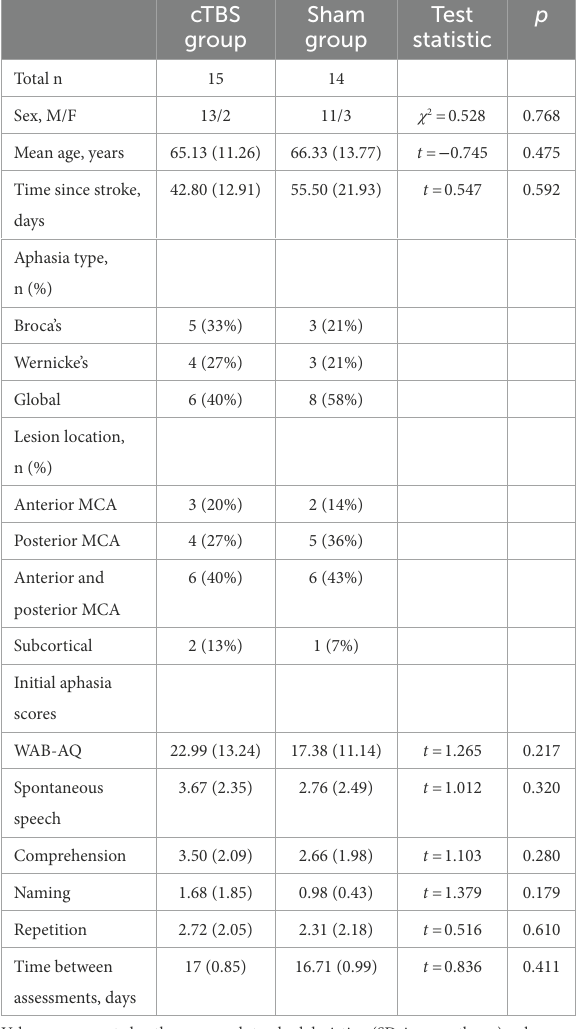
TABLE 1 Demographic and clinical characteristics of the